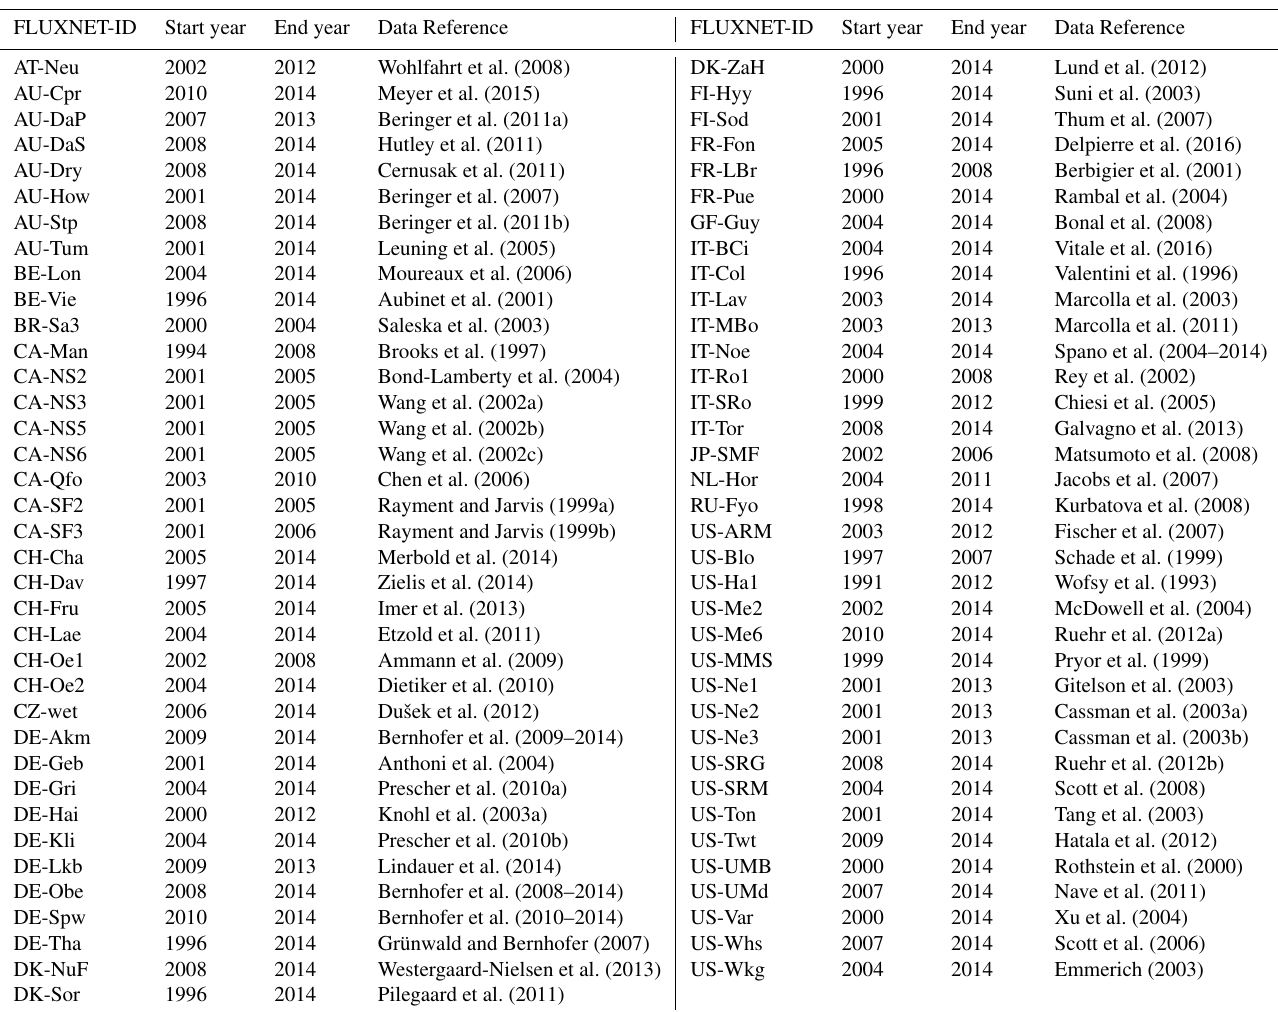
Table A2. List of FLUXNET sites used for the generation of artificial datasets and the time period used.